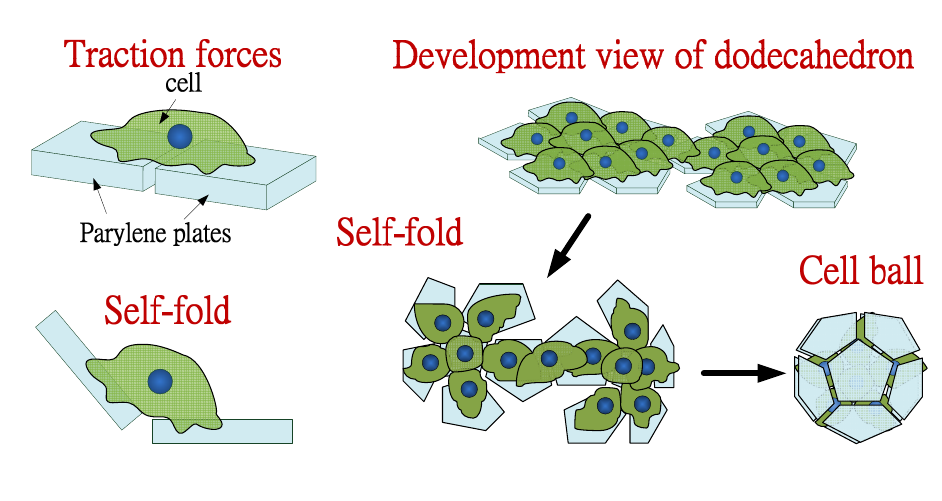
Figure 4. Conceptual illustration of assembly of micro-sized three dimensional structure by cell traction forces. A dodecahedron (cell ball) is folded by the cells. During the folding, other types of cells are also encapsulated into the cell ball for heterotypic three dimensional co-culture